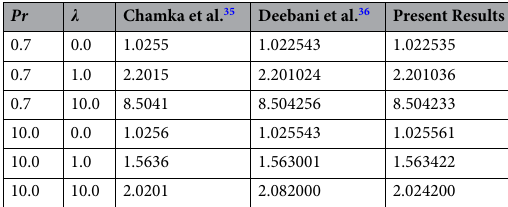
Table 1. The comparative outputs with respect to x.